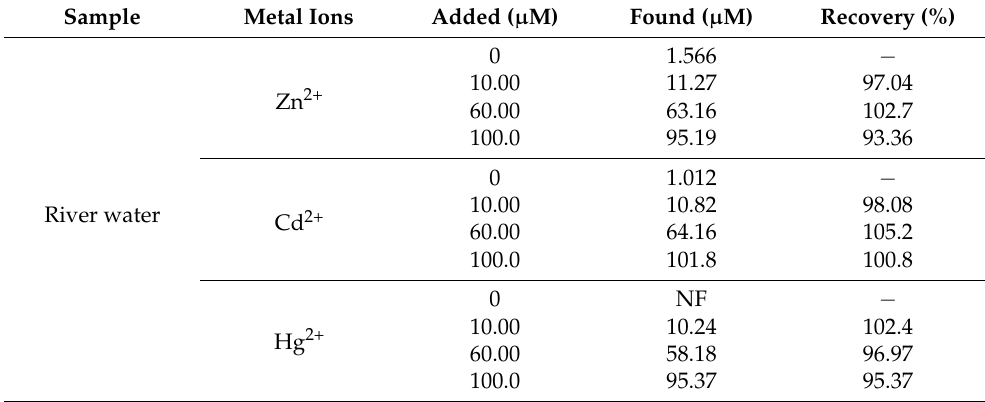
Table 3. Analytical results of real river water samples using this method (n =